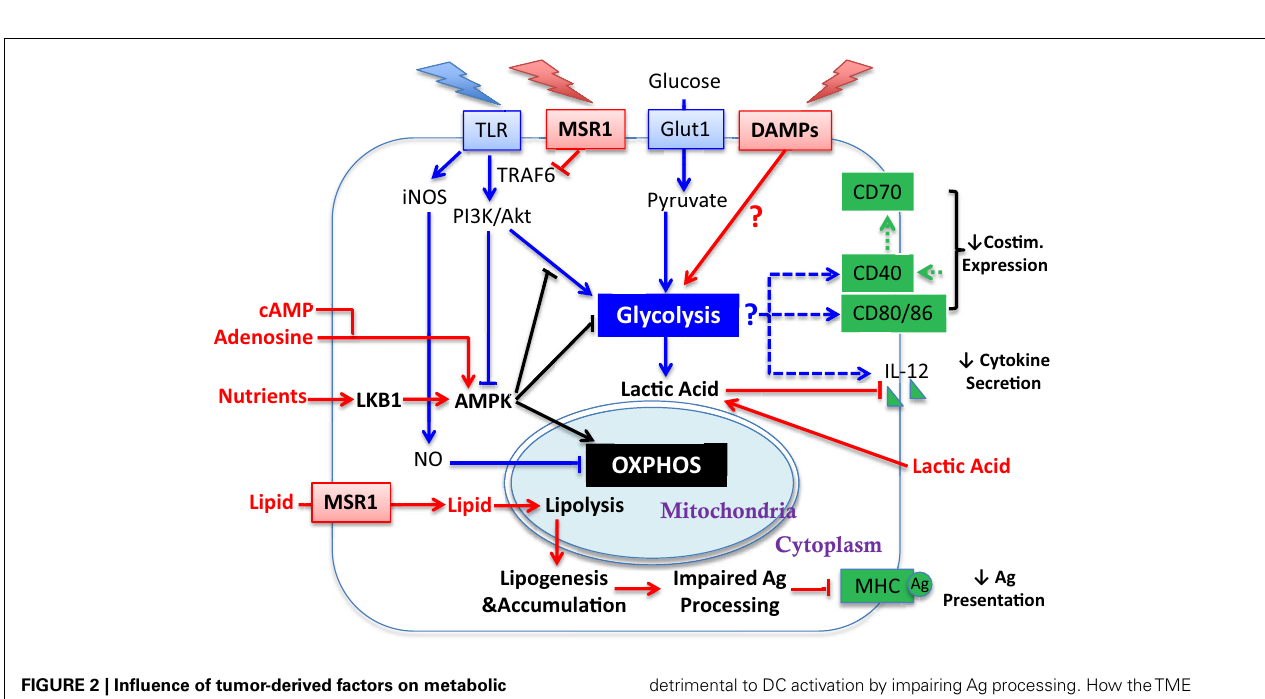
FIGURE 2 | Influence of tumor-derived factors on metabolic regulation of DC activation . Illustrated here are tumor-derived factors (in red) and their impact/potential impact on metabolic pathways (linked by red arrows) for DC activation. Other symbols are defined the same way as in Figure 1 . Lipid accumulation is